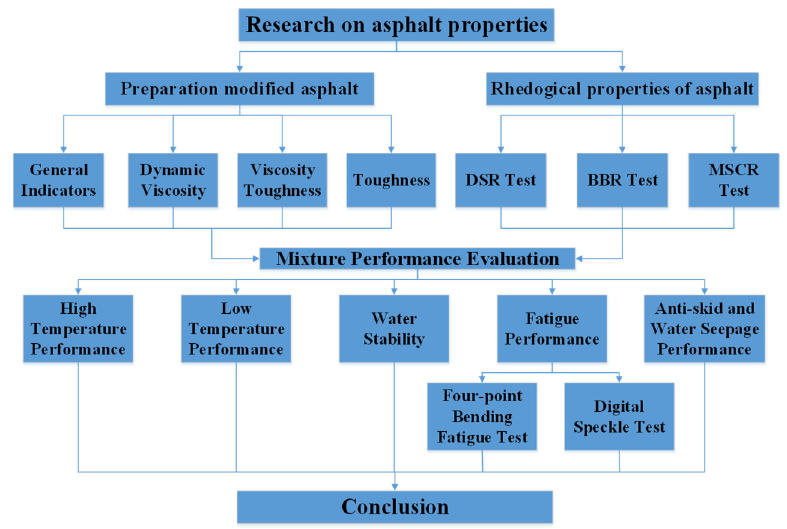
Figure 1. Design of the experiments.